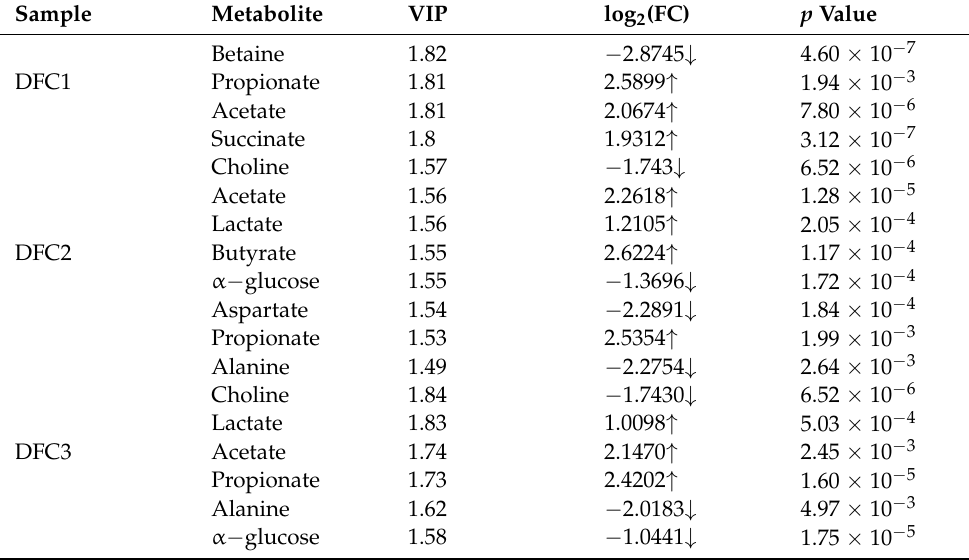
Figure 5. Representative volcano plots of major differential metabolites after DFC fermentation (i.e., volcano plots of DFC2). Note: Metabolites significantly up-regulated in red, metabolites significantly down-regulated in blue, and metabolites with no significant differences in gray. Table 2. Summary of the main differential metabolites of different DFCs after fermentation.